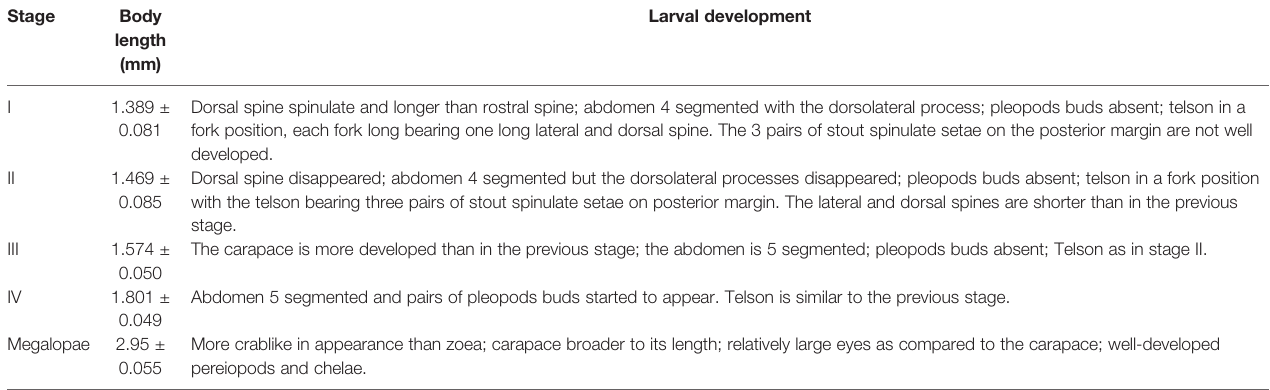
TABLE 4 | Description of the larval development stages of Segonzacia mesatlantica according to Arshad et al. (2006); and Kado et al.